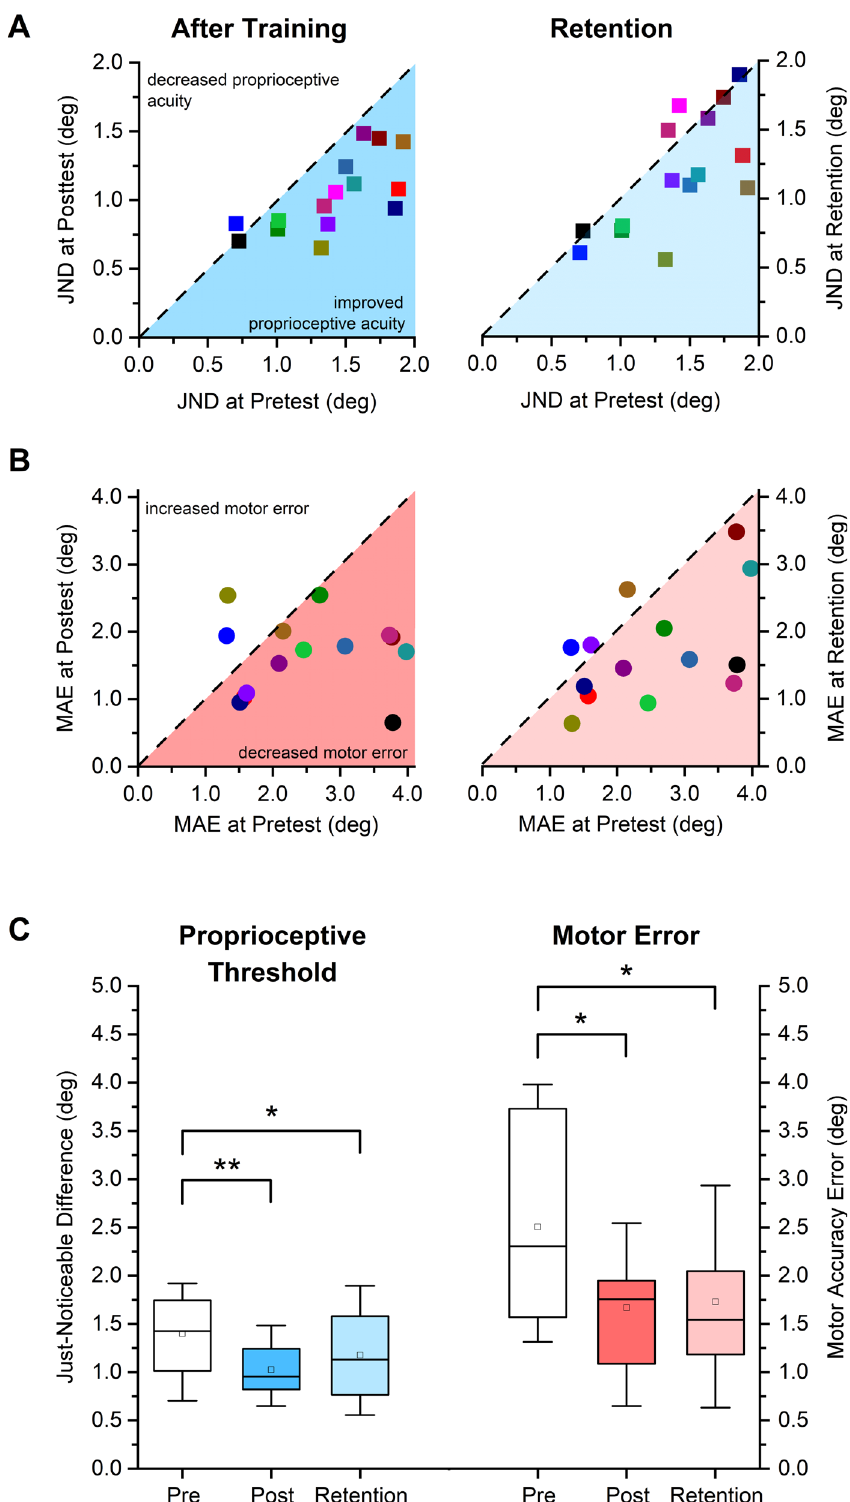
Figure 2. Sensorimotor effects of training on the trained right wrist as measured by the proprioceptive Just-Noticeable Difference threshold and the Movement Accuracy Error. Each colored symbol (square or circle) indicates the data of a particular participant after training and at retention. ( A) JND thresholds for each participant at posttest and retention are mapped against their pretest thresholds. Dashed diagonal line represents the line of equality, i.e. indicating no change due to training. ( B) Individual MAE values at posttest and retention are mapped against their pretest values. ( C) Boxplot indicating the distribution of JND and MAE at pretest, posttest and retention. Boxes represent the range between 25 to 75th percentiles. Line within the box represents the median. The upper and lower whiskers extend to + 1.5 and − 1.5 inter-quartile range, respectively. **indicates p < 0.001, * indicates p <